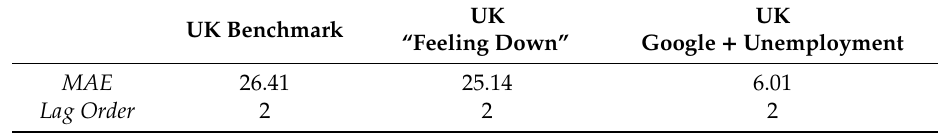
Table 5. Statistical model results for the UK applying the NNAR approach.